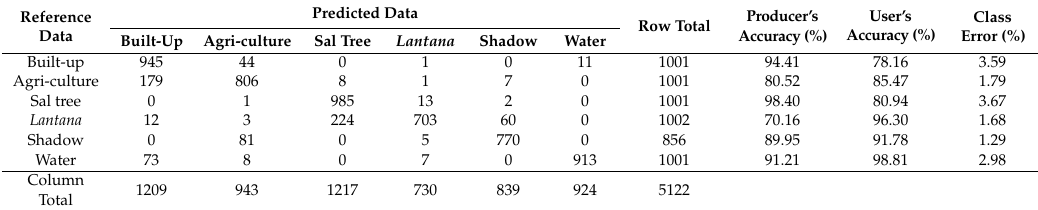
Table 3. Classification accuracy matrix for SPOT-6.